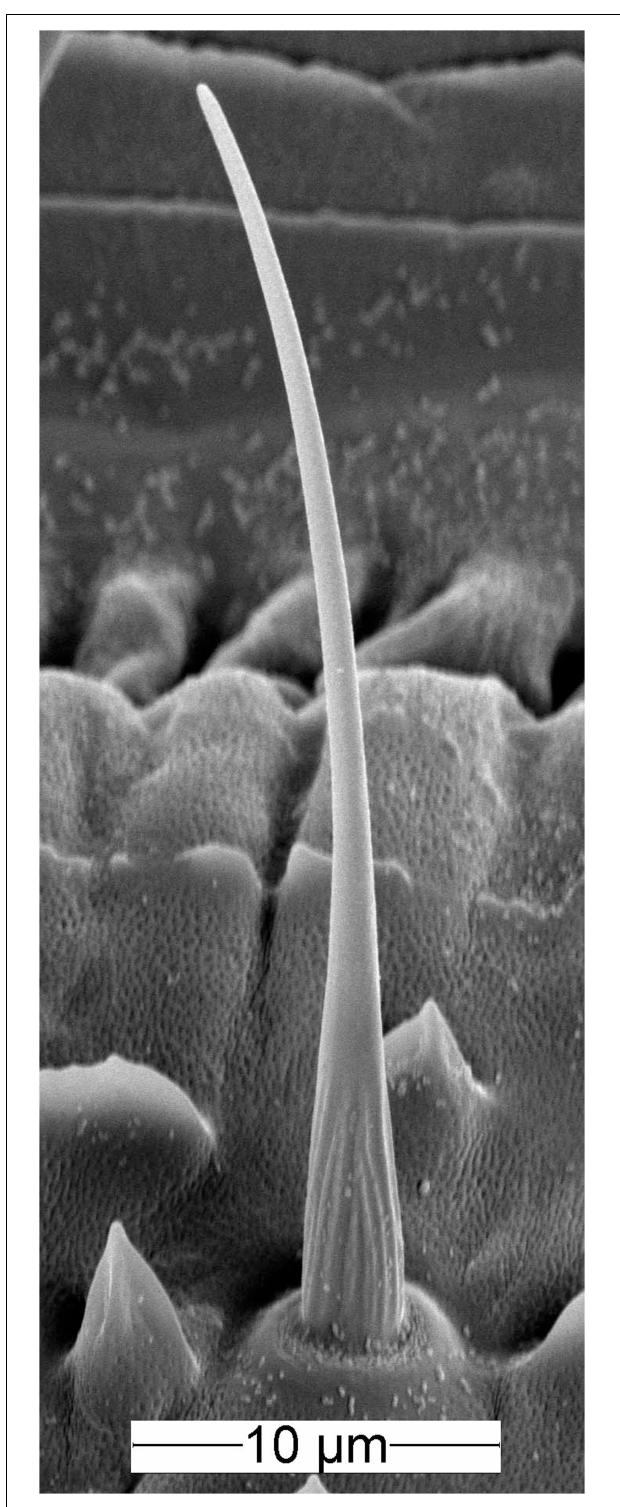
FIGURE 2 | Scanning electron micrograph of the olfactory sensillum on the cockroach antenna containing the ON and OFF ORNs. The sensillum has a slender, hair-like form with a slightly curved tip. The basal part of the shaft wall is grooved, the distal part is smooth and perforated by pores.